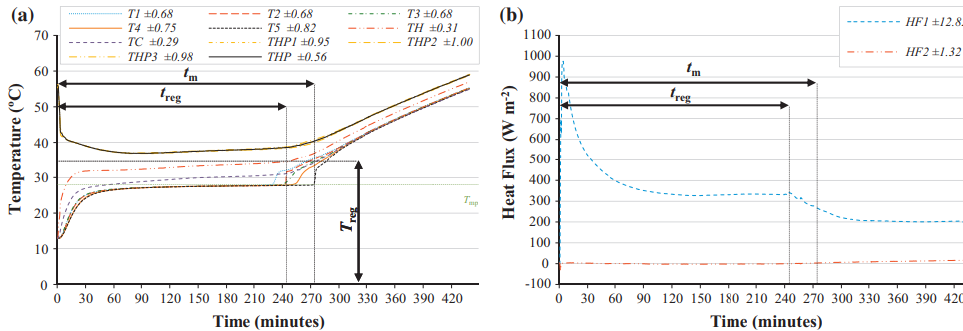
Figure 24. Evolution of the average measured ( a ) temperatures and ( b ) heat fluxes for the 34 W power level charging phase of the 5 cavities test sample filled with the free-form PCM-RT 28 HC. Reprinted with permission from Ref. [45]. 2015, Elsevier.